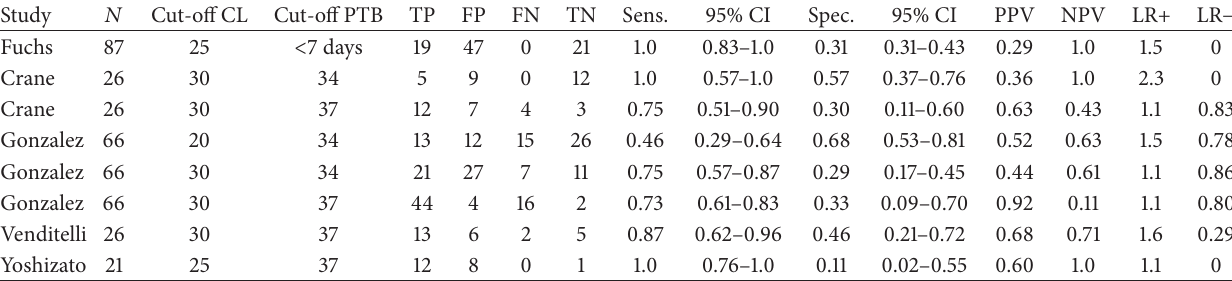
Table 2: Observed sensitivity and specificity for each study with 95% CI.